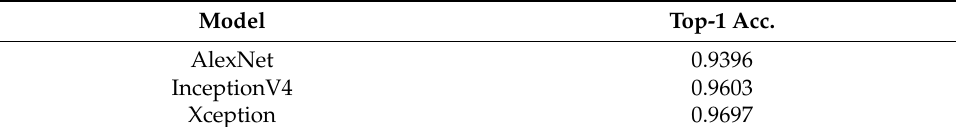
Table 3. Final result after confidence comparison.